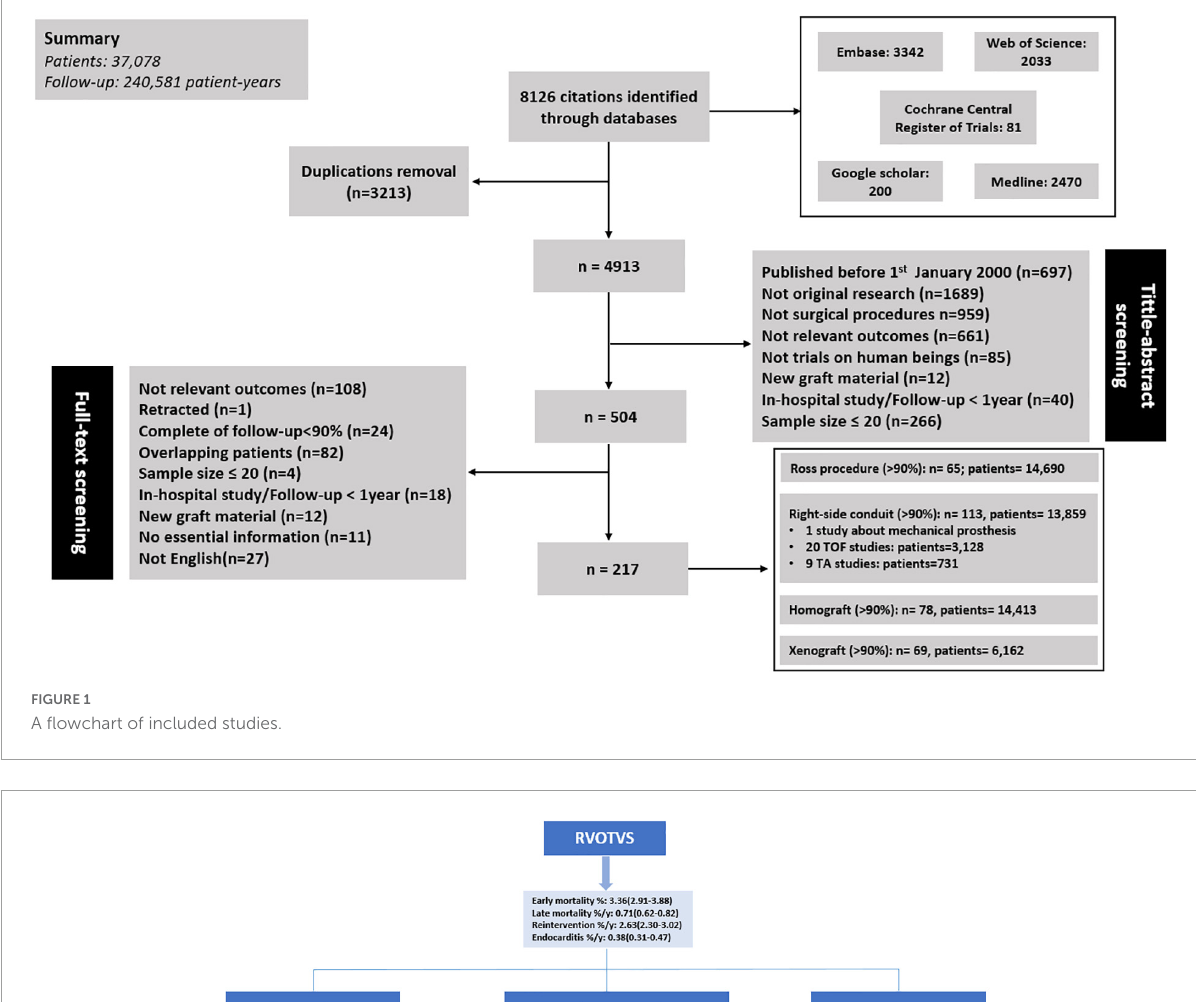
FIGURE1 A flowchart of included studies.